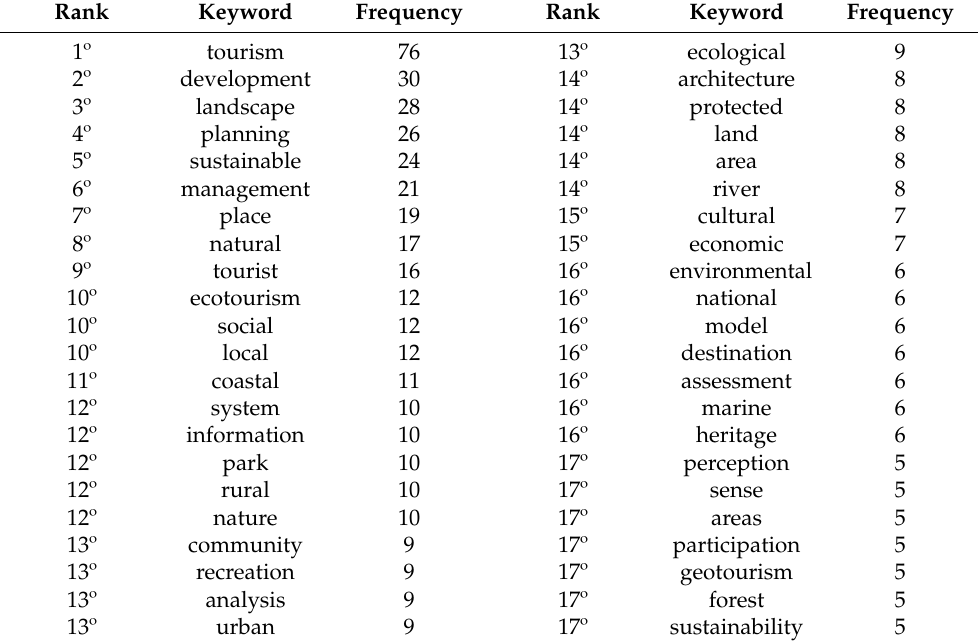
Table 4. Keyword frequency analysis—keywords related to tourism and planning in natural spaces ( n = 1432). Ranking of words with frequency greater than